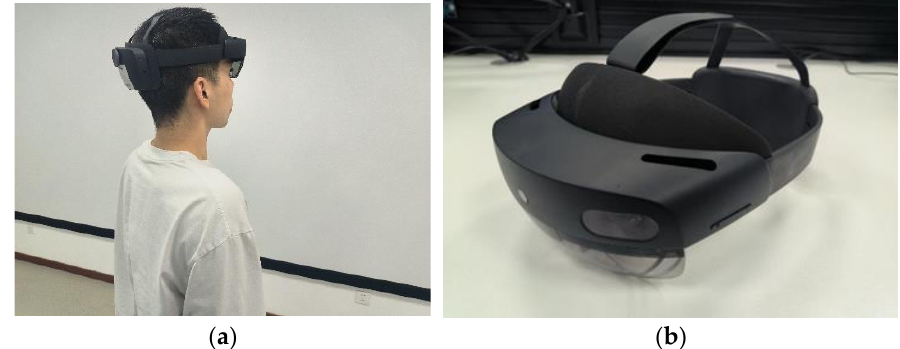
Figure 1. Visual presentation equipment and experimental scene: ( a ) subjects wearing the device; ( b ) Hololens2 display device.